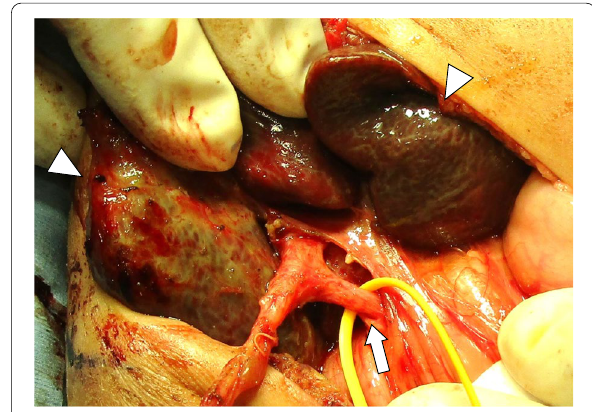
Fig. 3 Intraoperative findings at 122 days of age (Kasai portoenterostomy). The liver (arrowhead) was firm and cirrhotic. The arrow indicates the common bile duct